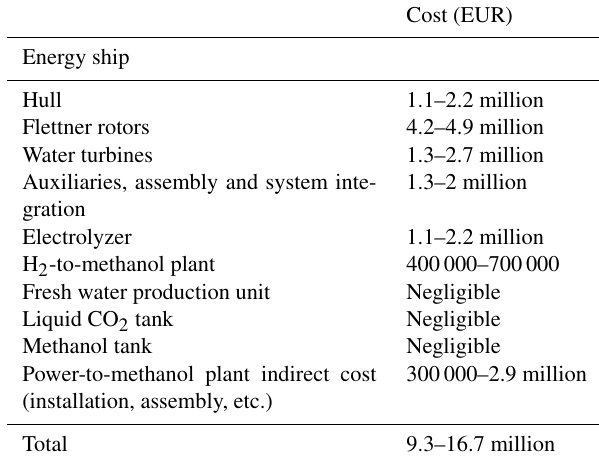
Table 2. Estimates of the capital cost of a prototype of the proposed energy